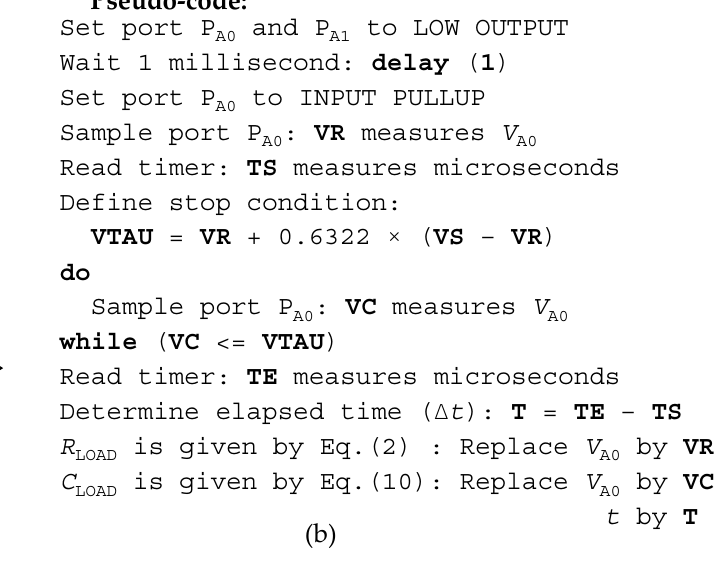
Figure 5. Set-up for recording a load impedance ( Z LOAD ) formed by a serial RC network. ( a ) Illustra- tion of the transient response to a voltage step at the input terminal ( P A0 ). ( b ) Pseudo-code used to implement the measurement of a serial RC network.